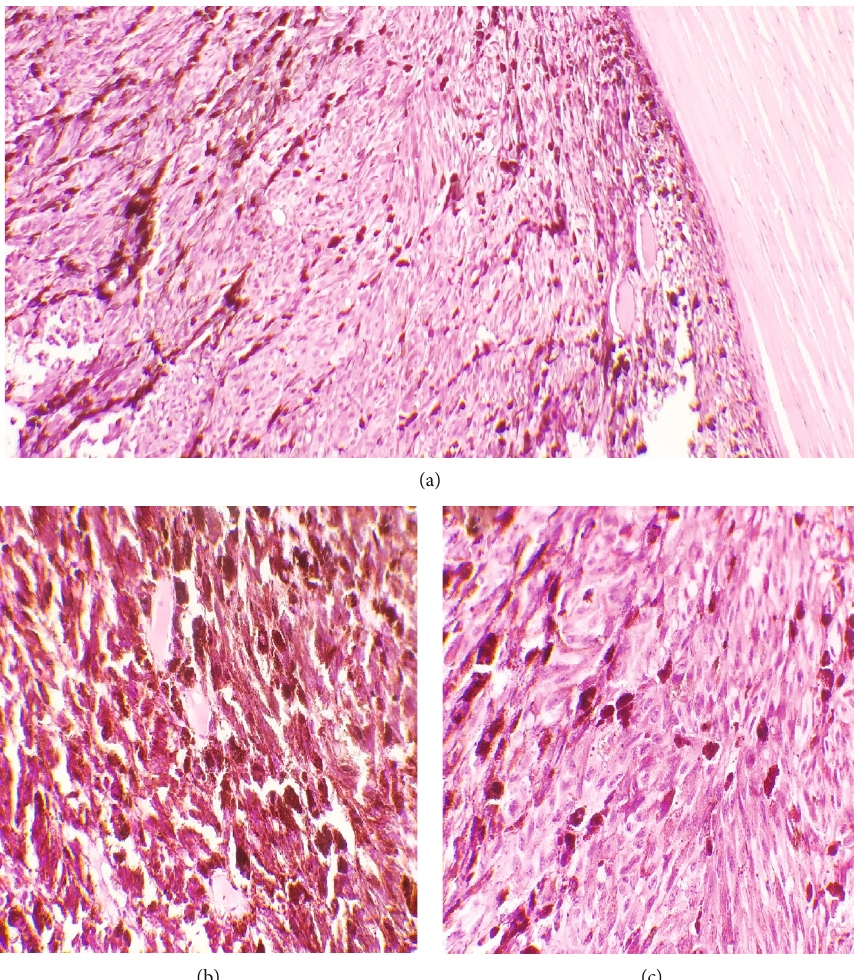
Figure 4: Pathologic fi ndings: (a) pigmented tumor composed of fusiform cells with brownish cytoplasm (hematoxylin-eosin stain, original magni fi cation 10x). Two di ff erent zones: (b) the fi rst one is highly pigmented with brownish cytoplasm, and (c) the second zone is less pigmented where we can see the nuclear details: fusiform cells with elongated nuclei and small nucleoli, without necrosis, atypia, or mitotic activity (hematoxylin-eosin stain, original magni fi cation